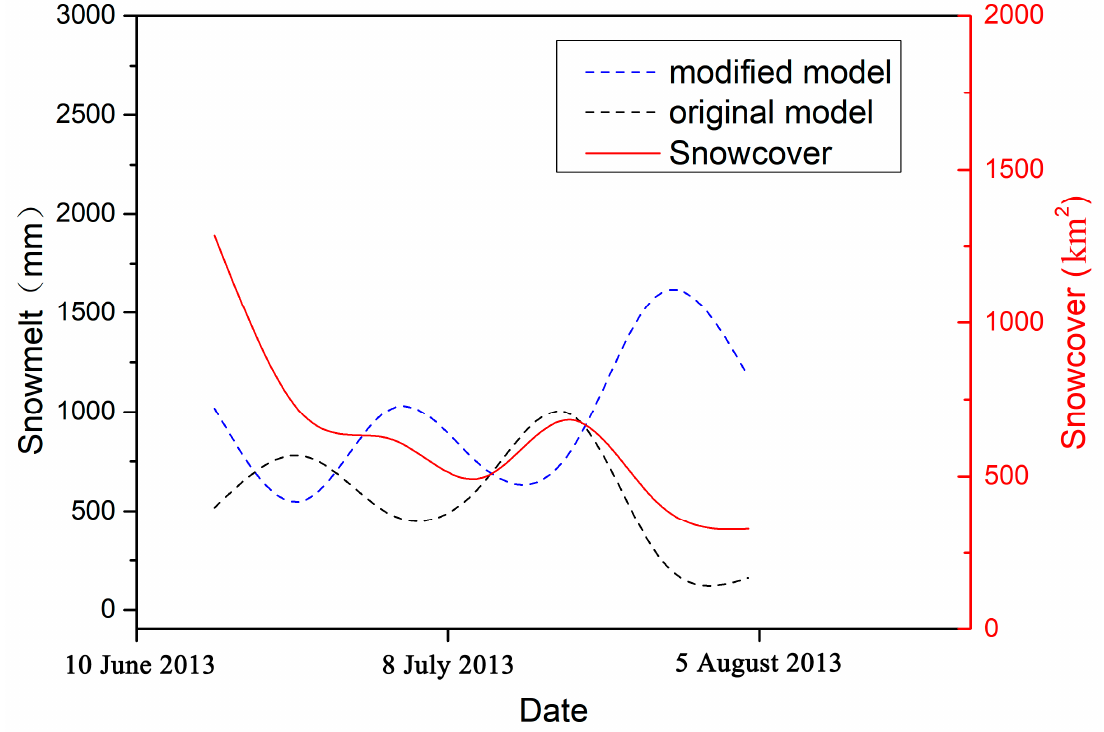
Figure 7. Comparison among 8 days’ calculated snowmelt volume from the original and modified model and snow cover area during the snowmelt season.